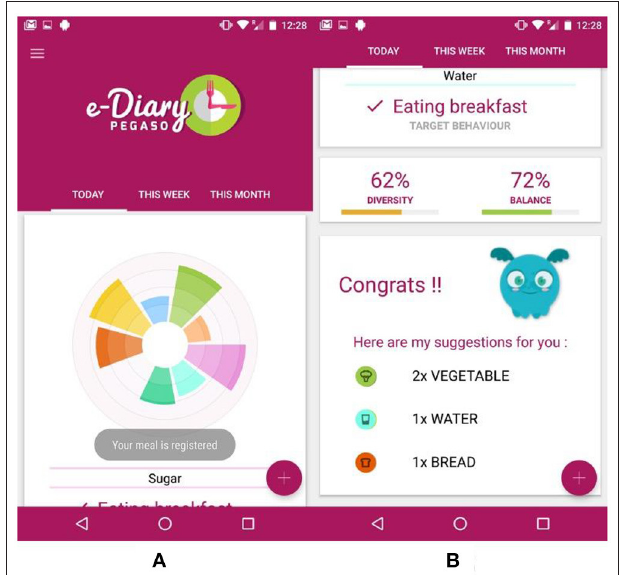
FIGURE 2 | e-Diary app main interface: (A) the radar chart showing the daily user’s meals divided in food groups; (B) this part of the interface shows the chosen target behavior, the diversity and balance indexes, and the recommendations for the next meal.